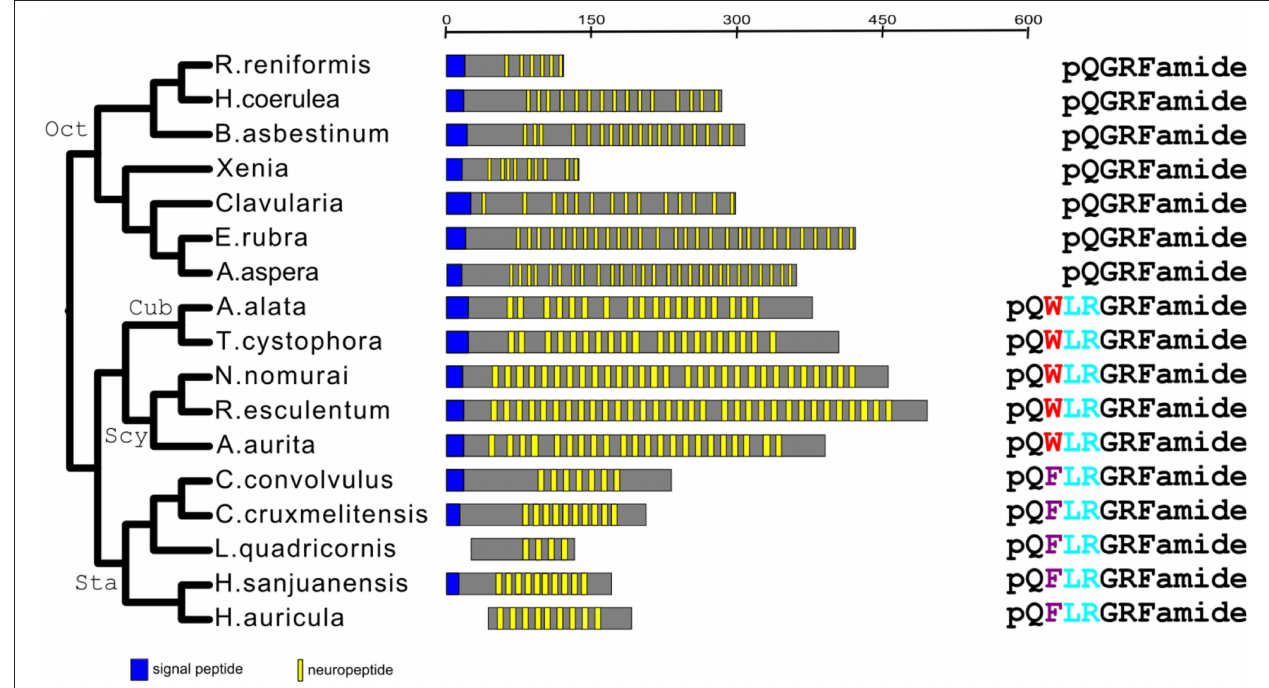
FIGURE 4 | Phylogentic tree analysis of all the identified GRFamide preprohormones from scyphozoans, staurozoans, cubozoans, and octocorallians. Like in Figure 3 , also this phylogenetic tree is in complete agreement with the phylogenetic tree given in Figure 1 . The panels are organized as in Figure 3 . The right panel gives the peptide sequences. This panel shows that all the Octocorallia species produce identical peptides, which is in agreement with their close phylogenetic relationship. Similarly, this panel shows that the cubozoans and scyphozoans produce identical peptides suggesting that these classes are more related to each other than to the staurozoans, which produce a slightly different